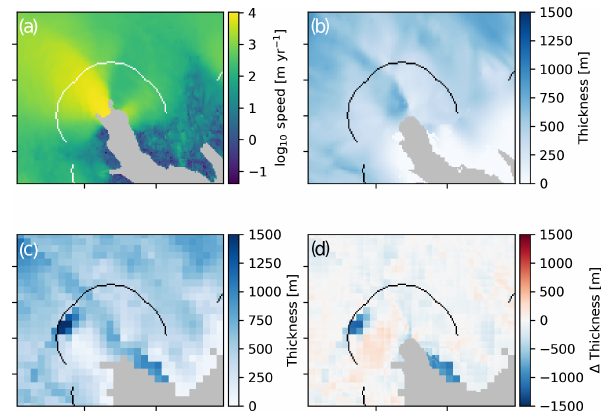
Figure B1. Differences between BedMachine (Morlighem et al., 2017b) and Bamber et al. (2013) near Køge Bugt. Panel (a) is base- line ice speed, (b) BedMachine thickness, (c) Bamber et al. (2013) thickness, and (d) difference computed as BedMachine − Bamber. The curved line is the gate used in this